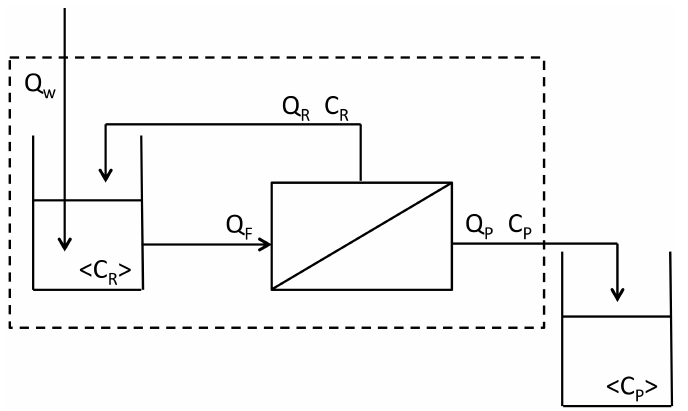
Figure 1. Flow system for ultrafiltration and constant volume diafiltration. Flow rates of diafiltration water ( Q W ), permeate ( Q P ), retentate ( Q P ), and feed solution ( Q F ). Instantaneous concentrations of permeate ( C P ) and retentate ( C P ). Mixing-cup concentrations of permeate (< C P >) and retentate (< C P